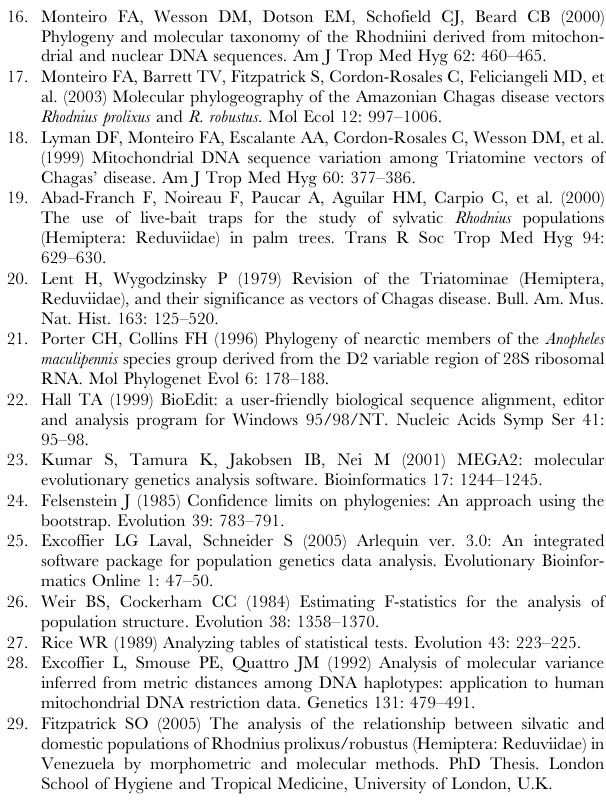
Table S3 The pairwise comparison of 33 populations from six Venezuelan States at 9 microsatellite loci, FST values below diagonal (p-values above) (Arlequin v2.1). Values in bold significant after sequential Bonferroni correction k = 528, p1 = 0.05/528, p # 0.0001. See Table 2 for population details. Table S4 The pairwise comparison of a subset of 20 populations at 10 microsatellite loci FST values below diagonal (p-values above) (Arlequin v2.1). Values in bold significant after